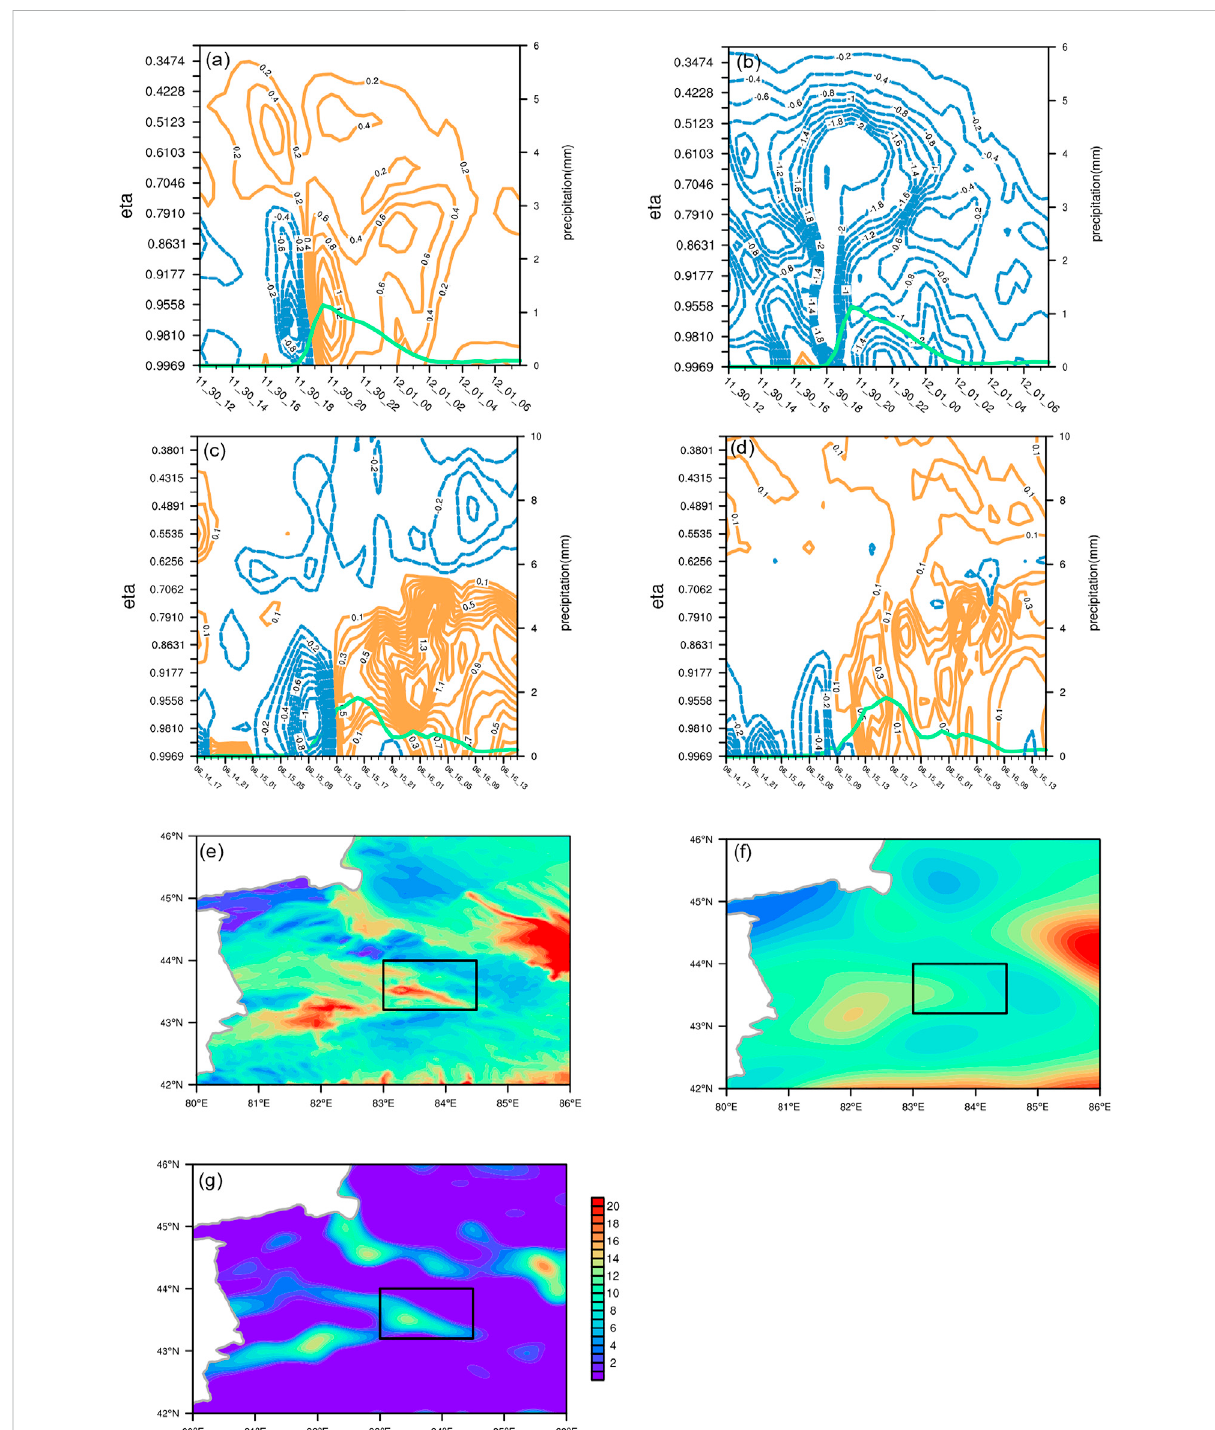
FIGURE 5 Domainaveraged (A) Q B Sm , (B) Q B Sd intheunitof10 − 7 g cm − 2 hPa − 1 s − 1 , (E) q , (F) q m ,and (G) q ’ at η =0.9558(shaded,unit:10 − 4 kg kg − 1 )at2330UTC on 30 Nov in winter case. Domain averaged (C) Q H Sm , (D) Q H Sd in the unit of 10 − 7 g cm − 2 hPa − 1 s − 1 in summer